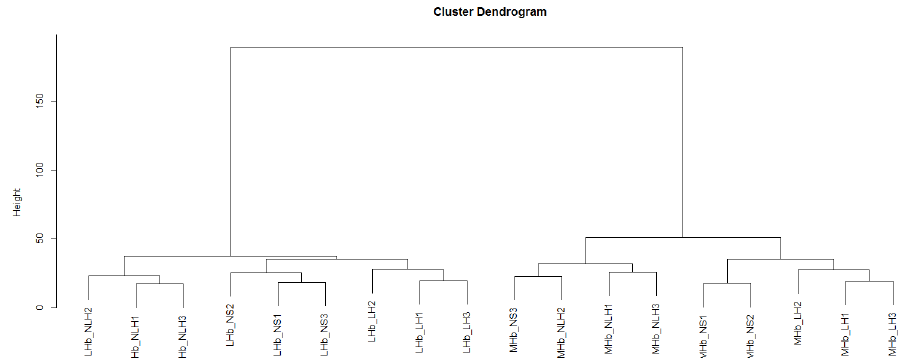
Fig 3. Cluster analysis. Fig 3 shows a cluster analysis based on the miRNA expression levels. The results show a clear segregation into medial (MHb) and lateral (LHb) habenular subgroups. The analysis further shows a clear segregation into the learned helpless (LH), non-learned helpless (nLH), and non-shocked controls